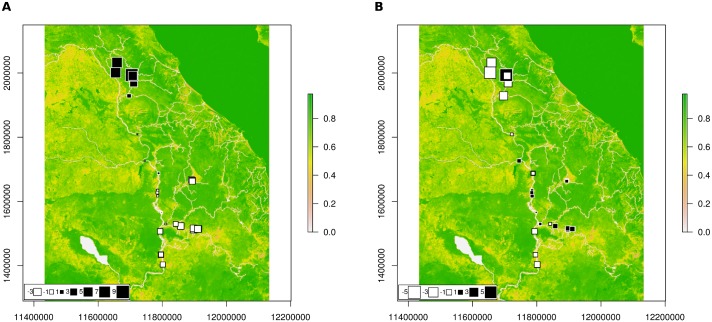
Plots of lagged global score onto geographical space for Neotricula γ-aperta.A, first PC; B, second PC. Large black squares represent populations that are well differentiated from those indicated by large white squares, whereas small squares indicate less differentiated populations. The colour ramp to the right represents resistance (to snail dispersal) from pure green (maximal resistance) to white (minimal resistance). Underlying map based on OpenStreetMap (OpenStreetMap contributors) data, freely available under the Open Database License.